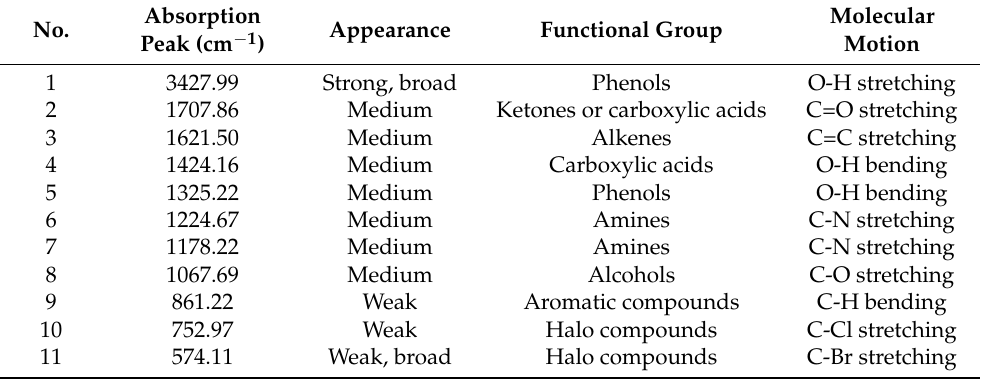
Figure 7. FTIR spectrum of the biogenic ZnO NPs synthesized using pomegranate peel extract. Table 1. Functional groups of the biogenic ZnO NPs synthesized using aqueous extract of pomegranate peel.